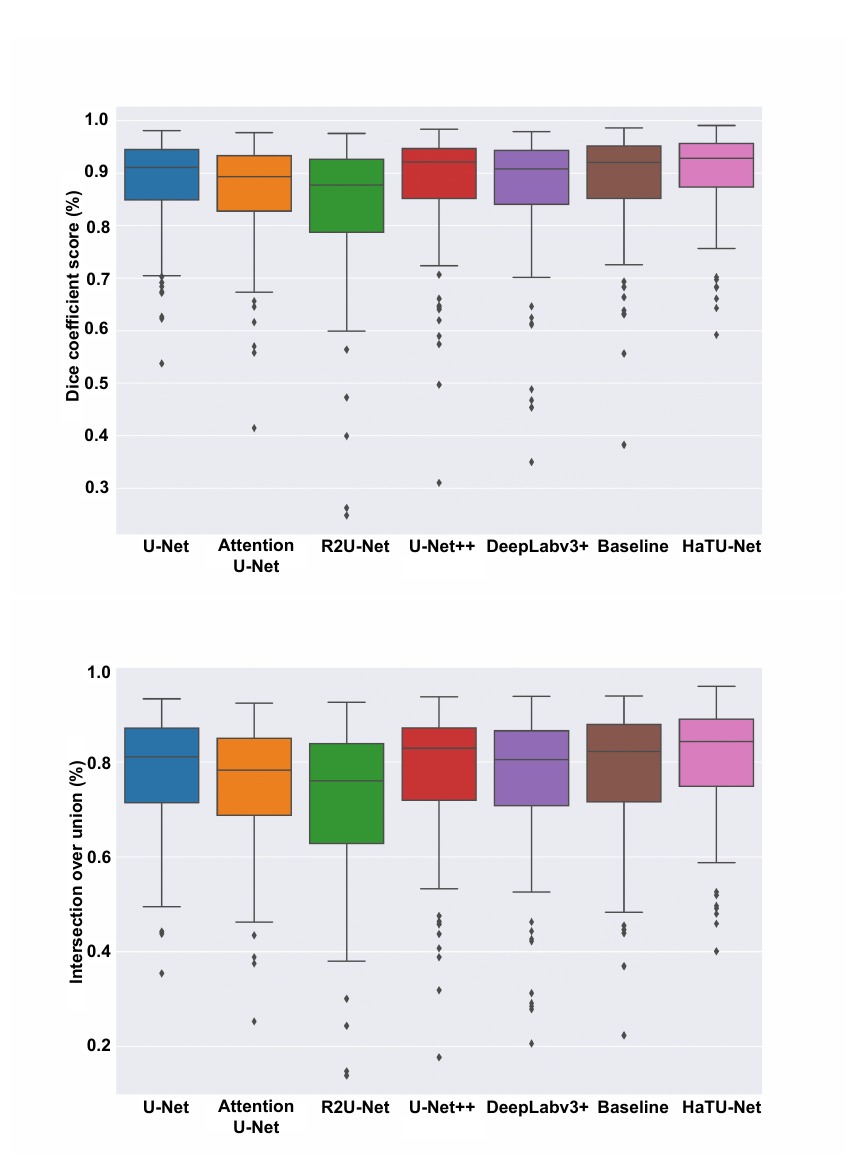
Figure 5. Boxplots of Dice and IoU scores of ovary